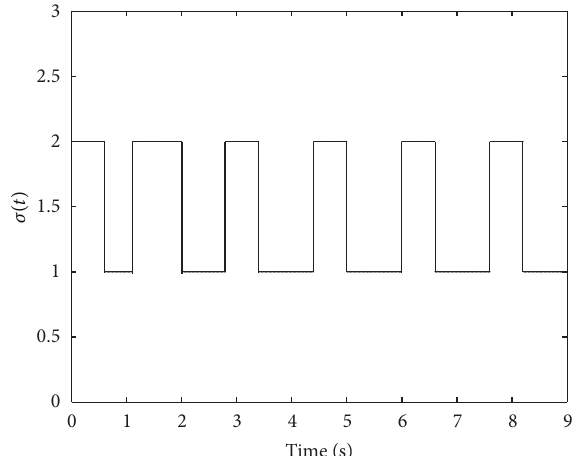
Figure 10: The switching signal 𝜎(𝑡) of the switched delay network (75) with average dwell